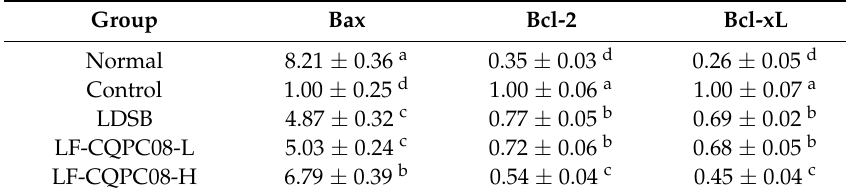
Table 9. Nrf2, HO-1, and GST- π mRNA expression in tongue tissue of mice (relative to multiple of control